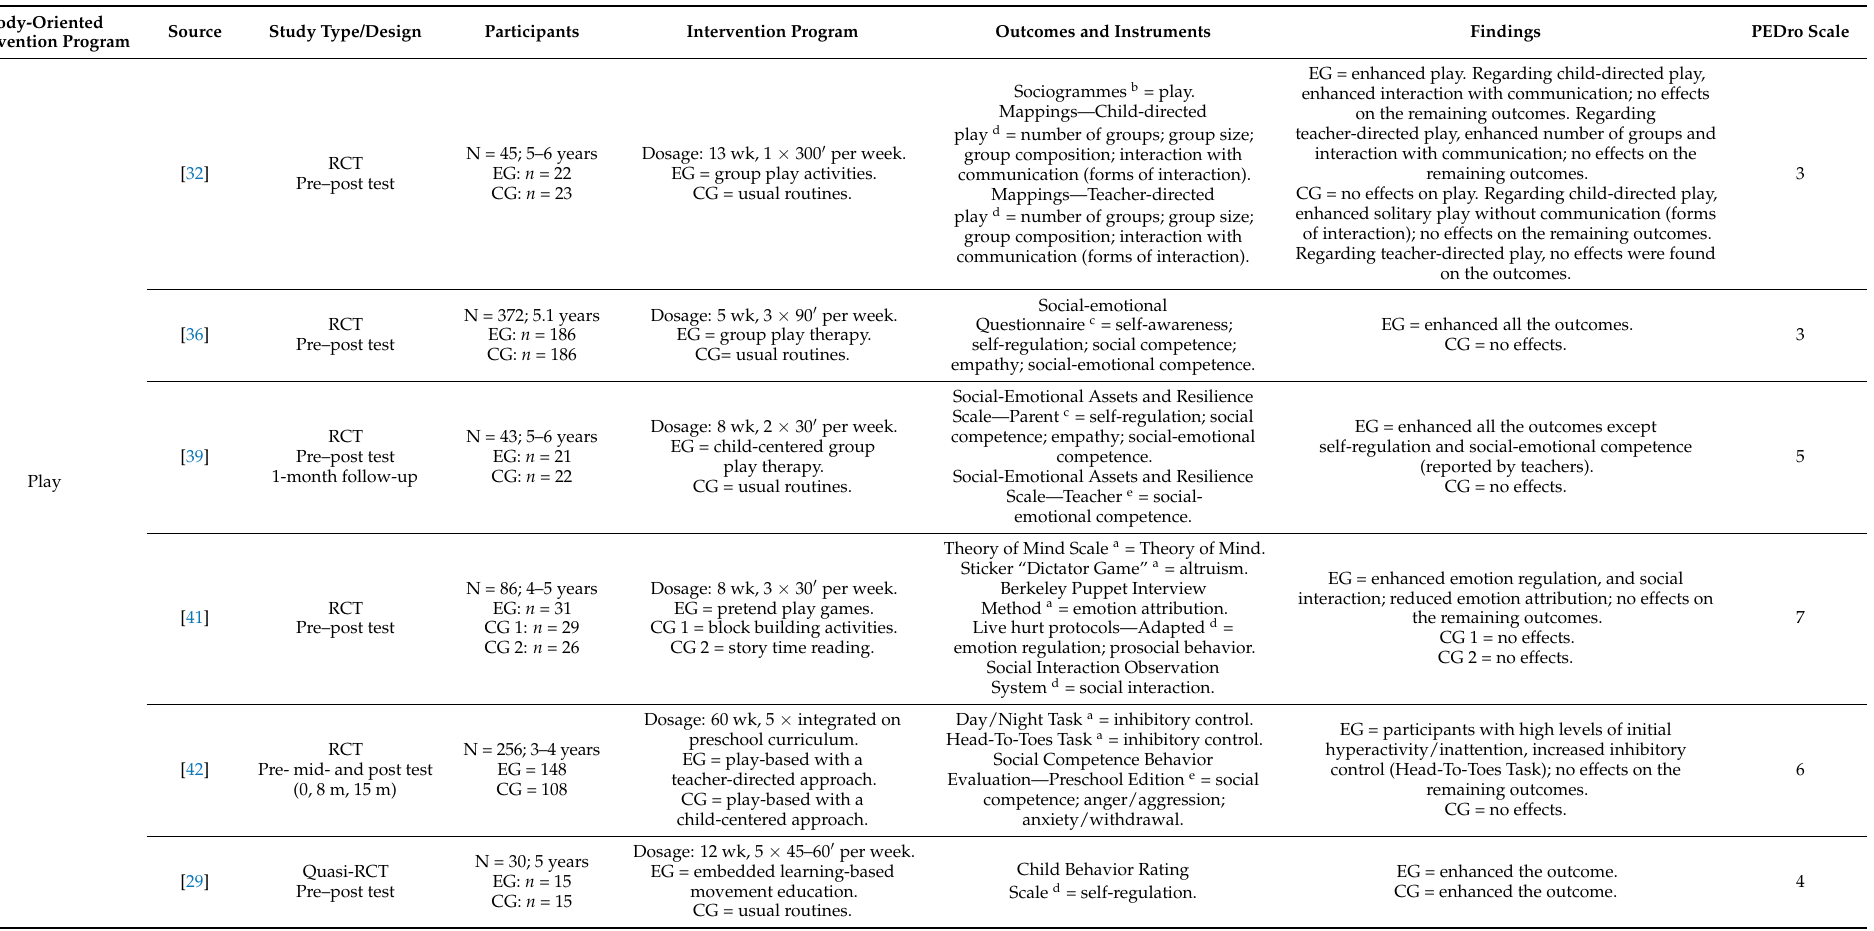
Table 1. Studies characteristics and methodological quality.